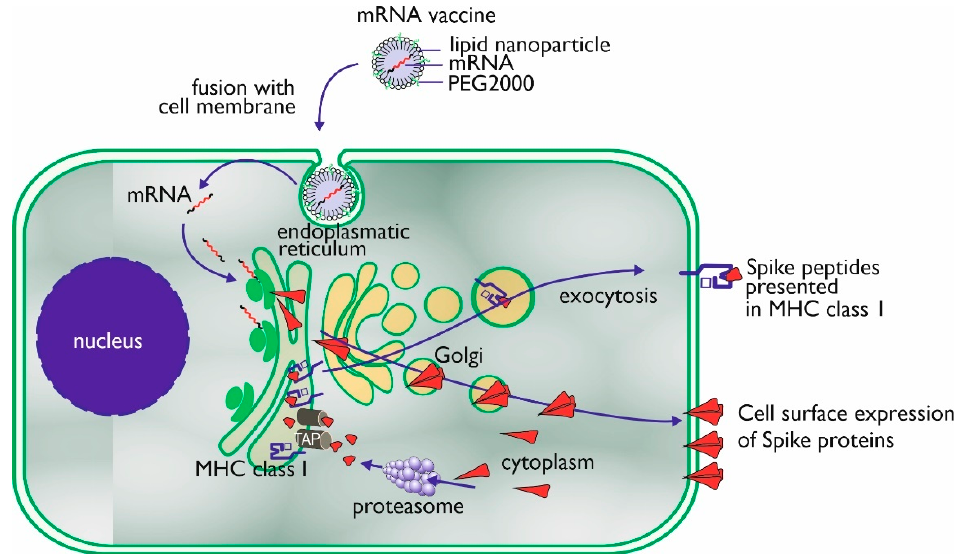
Figure 2. Uptake, processing, and MHC class I presentation of Spike proteins encoded by an mRNA vaccine.